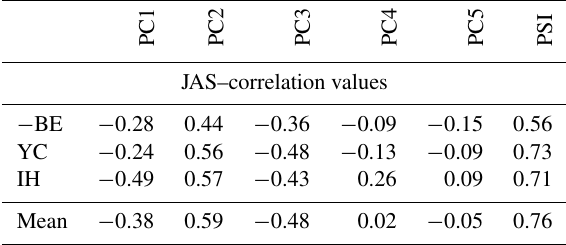
Table 2. Monthly (JAS) Pearson correlation coefficients of individ- ual leading five PCs in the 200hPa zonal wind as well as the PSI with the split-jet indices introduced in the methods section (Sect. 2). By construction, the Bals-Elsholz et al. (2001) index becomes nega- tive during split events and its sign is therefore reversed. Bold values are significant at the α = 1%